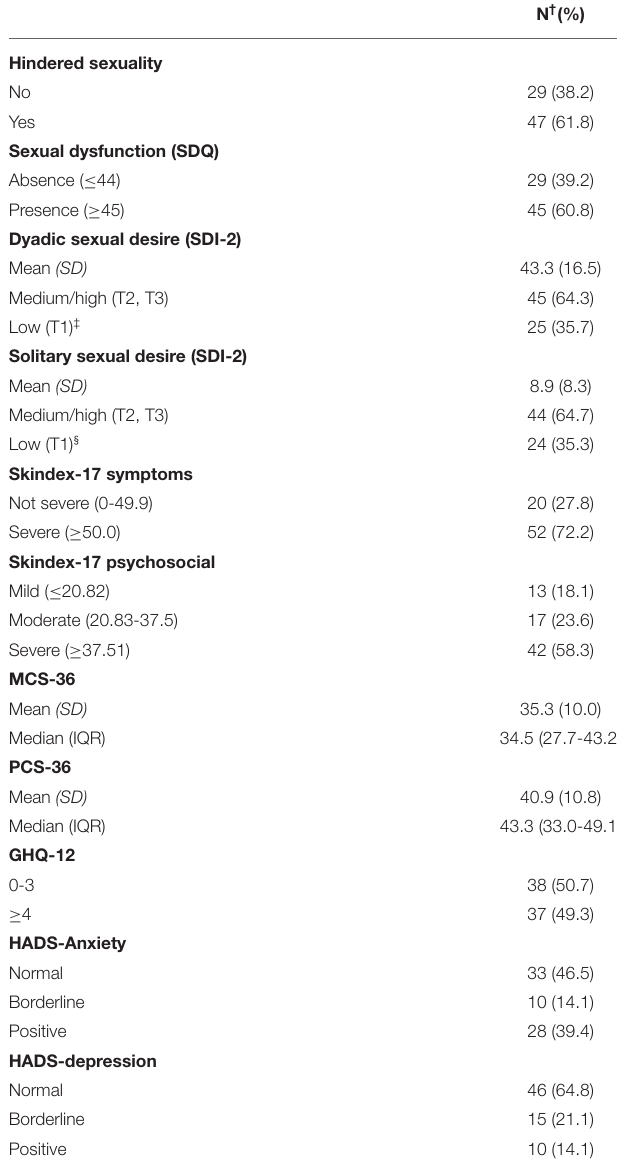
TABLE 2 | Sexual health, quality of life, health status, psychological distress, anxiety and depression in 77 patients with Hidradenitis